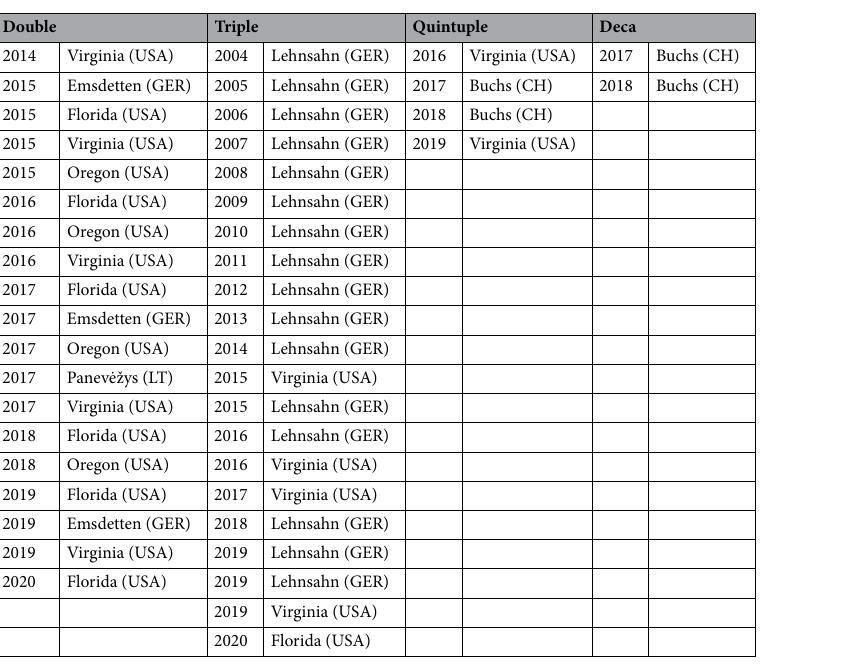
Table 2. All races included in the statistical analysis sorted by race type and